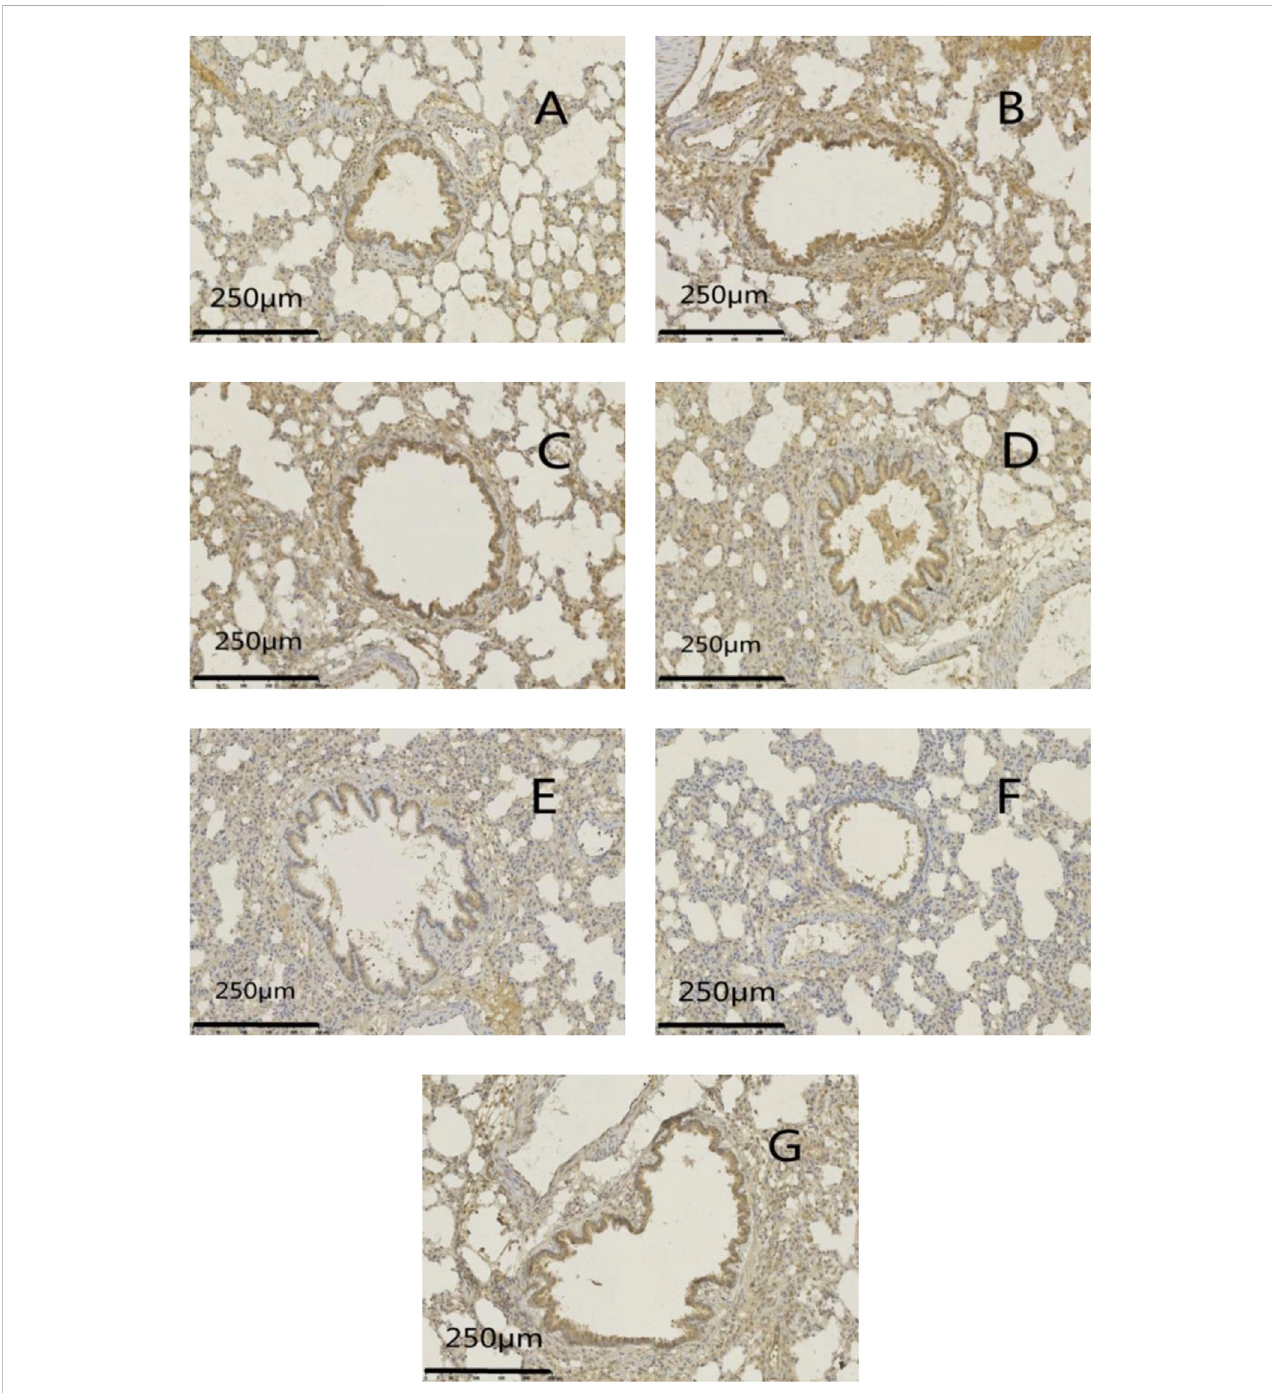
FIGURE 10 Effects of GSZC granules on lung MUC5AC protein expression in rats suffering from asthma. (A) is the normal group, (B) is the model group, (C) is the GSZC low dosage group, (D) is the GSZC moderate dosage group, (E) is the GSZC high dosage group, (F) is the Dexamethasone acetate group, (G) is the Yupingfeng granules + Liujunzi pills group, respectively. Scale bar: 250 μ m. Magni fi cation: